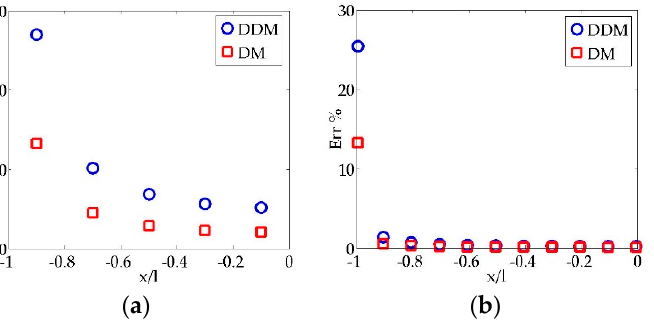
Figure 7. Percentage errors of the DDM and the DM with ( a ) 5 crack elements and ( b ) 100 crack elements.